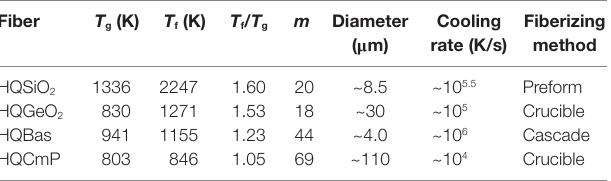
TaBle 1 | characteristic parameters and preparation methods of the hQ glass fibers.